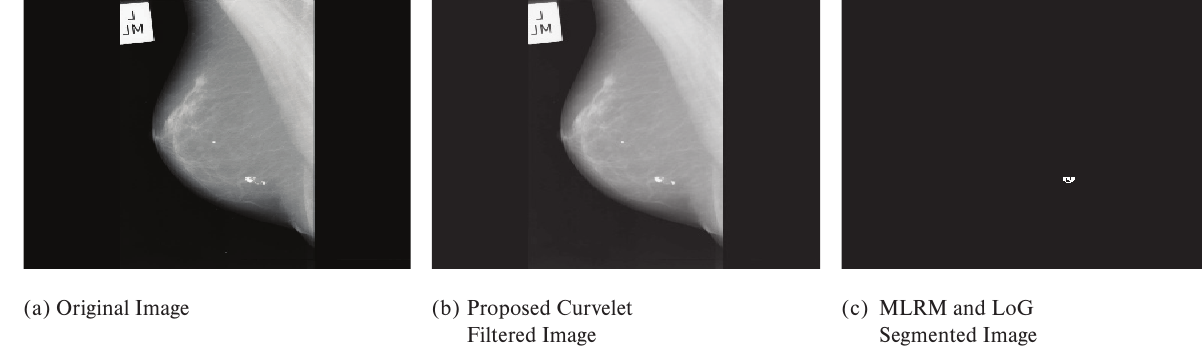
Fig 1. Mammogram Image mdb075 (Referred from MIAS database).